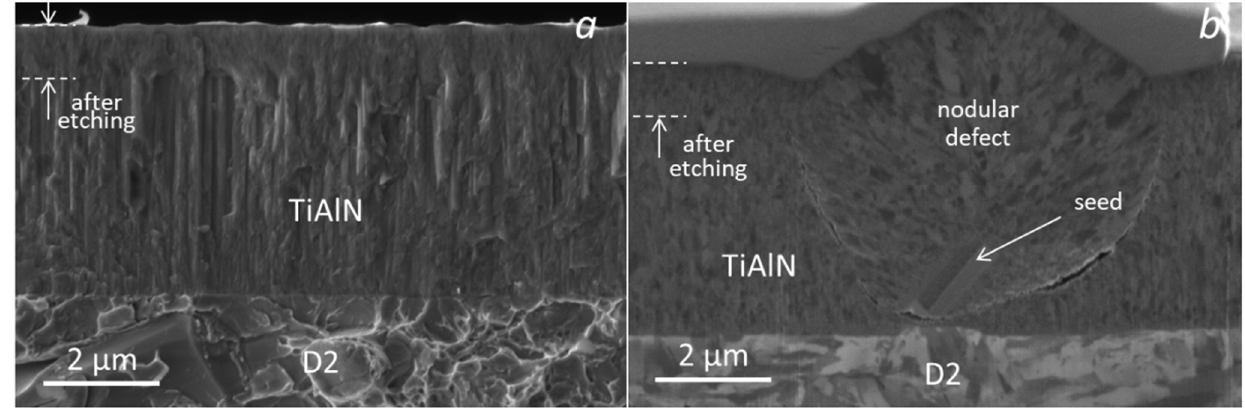
Figure 2. Fracture cross-sectional SEM image ( a ) and SEM image of FIB cross-section ( b ) of as-deposited TiAlN coating.